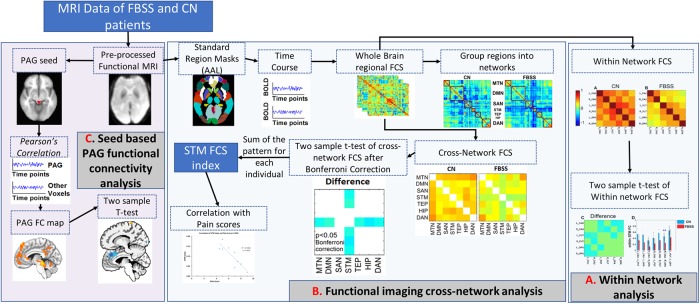
Summary of methodology and data analysis.A Regional FC within STM network for CN, FBSS. A two-sample t test is performed to analyze the difference in regional FC between CN and FBSS. B. Functional imaging cross-network analysis. Start from the pre-processed functional MRI imaging, using SPM to register the imaging into standard template with anatomical automatic labeling (AAL) maps. Each brain region’s BOLD signal is extracted and correlated with each other region’s BOLD signal to construct the whole brain regional FC network. The regions are then grouped into seven well known networks, i.e. MTN, DMN, SAN, STM, TEP, HIP and DAN. The FC across the seven networks (cross-network FC) is calculated for each individual. Two-sample Wilson-rank test is performed to characterize the difference between FBSS and control (CN) group. The STMFCS index is calculated individually based on the difference pattern and then correlated with the pain level scores. C. Seed-based PAG FC analysis. Each subject’s PAG whole brain FC is obtained by first extracting PAG ROI using MNI coordinates.[19, 20] This is followed by ROI co-registration to the functional data. The time series of all voxels within the co-registered region of interest (ROI) are averaged to obtain each subject’s PAG time series. Voxelwise Pearson cross-correlation coefficients (CC) between the seed region and the whole brain are calculated and then subjected to a Fisher transformation to improve normality. Finally, a two-sample student t-test is used to compare PAG FC between the CN and FBSS groups and results are corrected using the AlphaSim program.